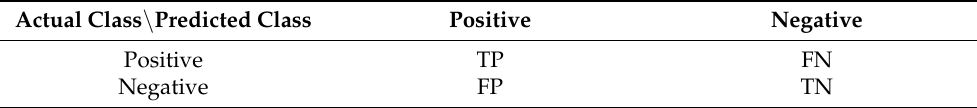
Table 10. Confusion